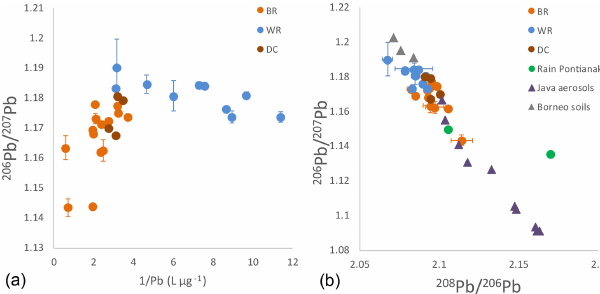
Figure 6. (a) Dependence of 206 / 207 Pb ratio on Pb concentra- tions for the different water samples. (b) Relationship between 206 Pb / 207 Pb ratio and 208 Pb / 206 Pb ratio. The error bars represent the standard